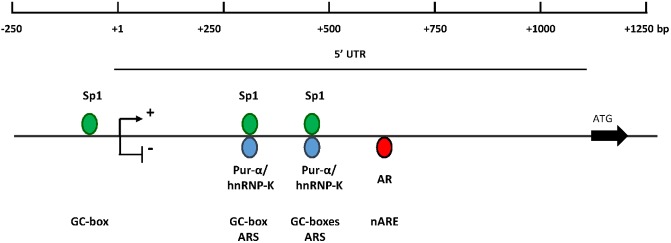
Model for regulation of the human AR gene.The organisation of positive (GC-box) and negative (ARS, nARE) elements in the promoter and 5’UTR of the AR gene are shown together with the relevant transcription factors.